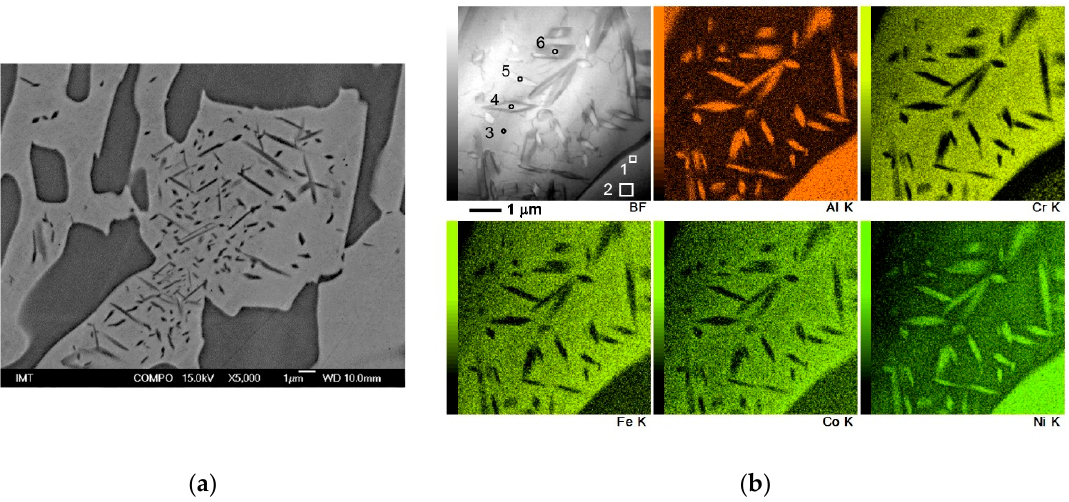
Figure 6. Electron microscopy characterization of the dilatometry sample (20 h at 800 ◦ C): ( a ) SEM-BSE image showing partial precipitation; ( b ) STEM bright-field image of precipitates with EDS point analyses and mapping. Table 1. Elements concentration in at% from EDS point analyses in Figure 6